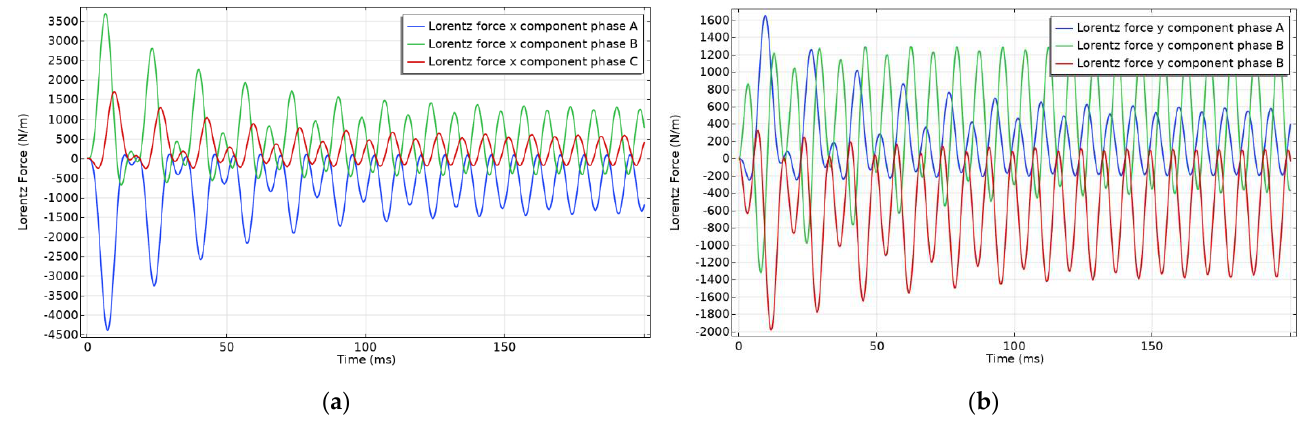
Figure 15. Electrodynamic forces on model 6 at 60 Hz: ( a ) in x direction; ( b ) in y direction.